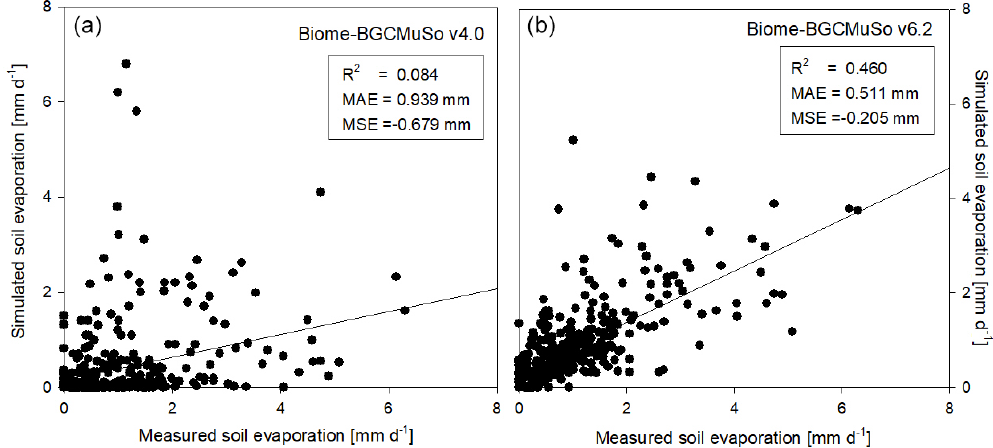
Figure 9. Comparison of the simulated (a : v4.0; b : v6.2 ) and observed daily soil evaporation representing the means of measured data obtained from six weighing lysimeter columns with bare soil at Martonvásár in 2020. R 2 , MAE, and MSE denote the coefficient of determi- nation, mean absolute error, and mean signed error (bias) of the simulated values, respectively.